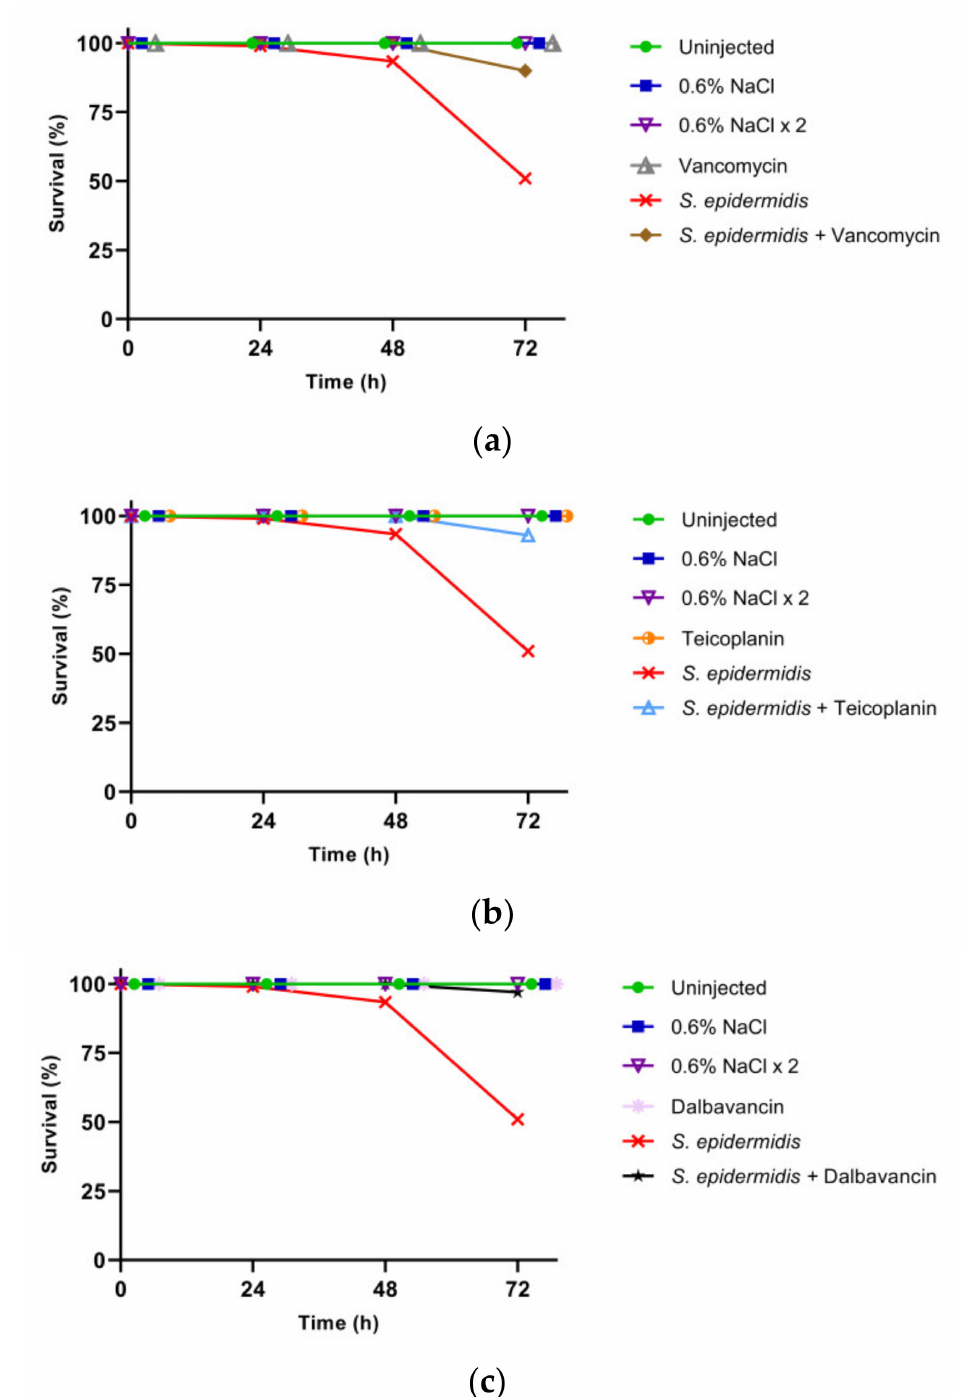
Figure 2. Survival rate. Curative efficacy of vancomycin ( a ), teicoplanin ( b ), and dalbavancin ( c ) (8.75 µ g/g larval body weight) on larvae infected with S. epidermidis (1.05 × 10 3 CFU). Results are from the same experiment run in parallel, using the same control groups (uninjected larvae and healthy larvae injected once or twice with saline solution) and infected